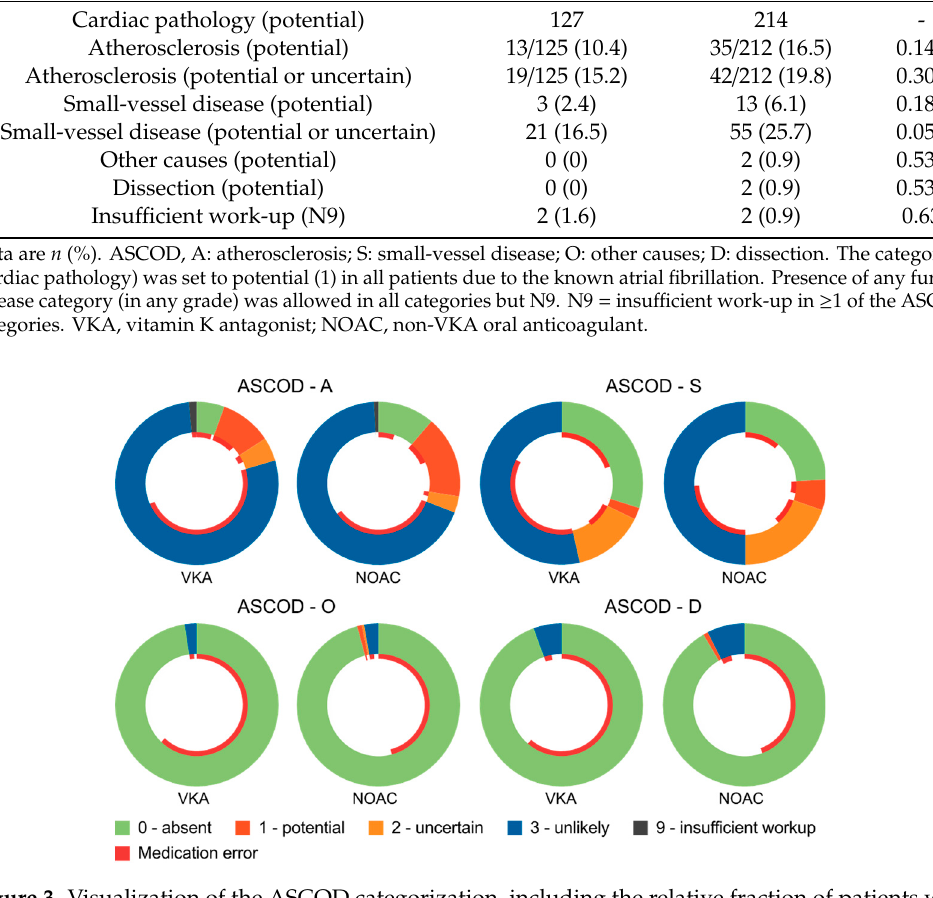
Figure 3. Visualization of the ASCOD categorization, including the relative fraction of patients with present ‘medication error’ with regard to each ASCOD category (inner red circle). Medication error was defined as either laboratory-based evidence of insu ffi cient anticoagulation (here defined as INR < 2.0 in the VKA-, or drug-specific concentration < 10 ng / mL in the NOAC-group, respectively) and / or dosage or dosing errors. ASCOD, A: atherosclerosis; S: small-vessel disease; O: other causes; D: